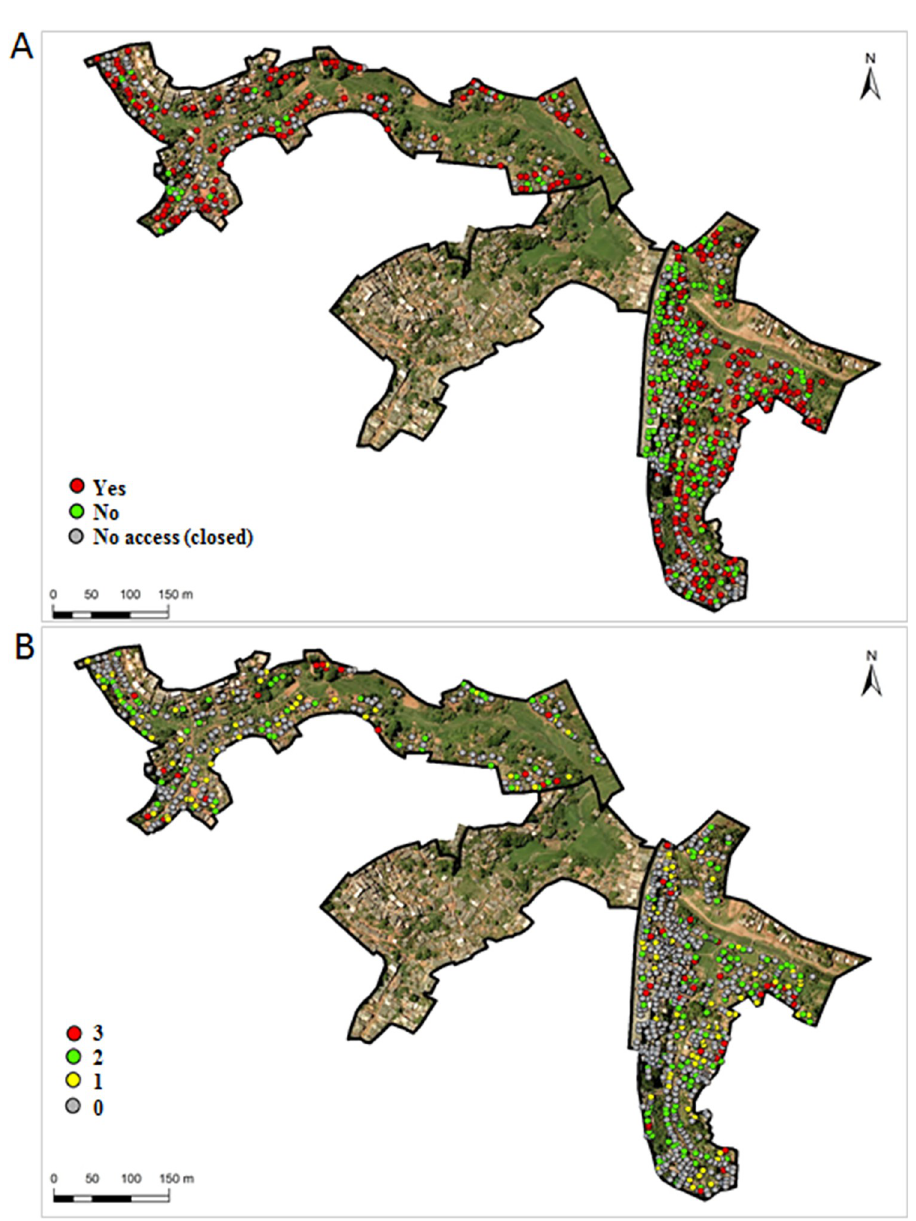
Fig 2. A. Area of study and distribution of households visited with or without need for rodenticide application in Pau da Lima, Salvador, Brazil. B . Number of rodenticide applications among households in need in Pau da Lima, Salvador,